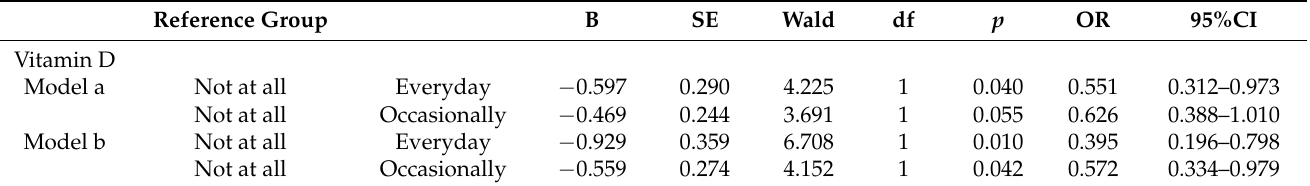
Table 2. Multivariate analysis of vitamin D supplementation (as categorical variable) (comparison between the MCI group and the AD group).